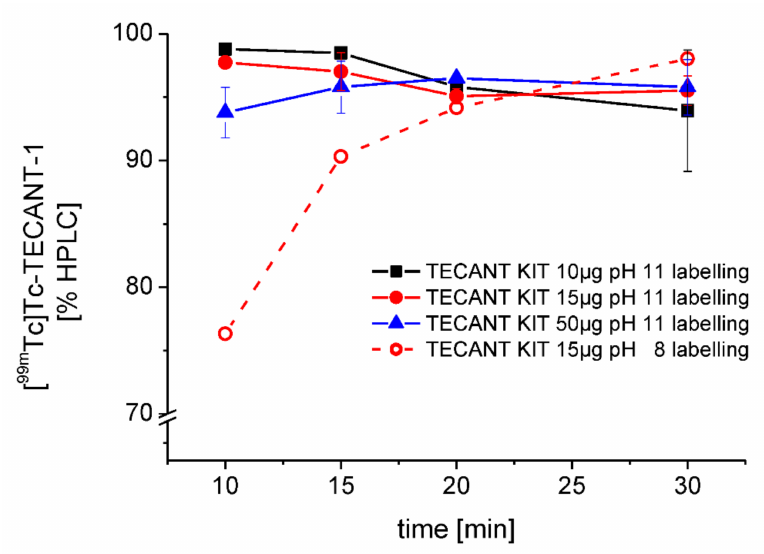
Figure 3. % of [ 99m Tc]Tc-TECANT-1 purity in dependence on the amount of the precursor, reaction time and the pH of the reaction solution, determined by